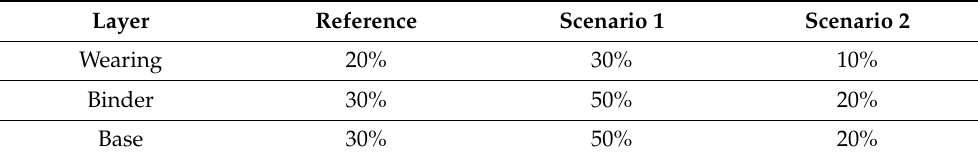
Table 4. Third case study. Share of RAP pavement considered in each scenario: Reference scenario (also applied to the first two case studies), first scenario with increased recycled RAP rate (enhanced circularity index), second scenario with decreased recycled RAP rate (lowest circularity